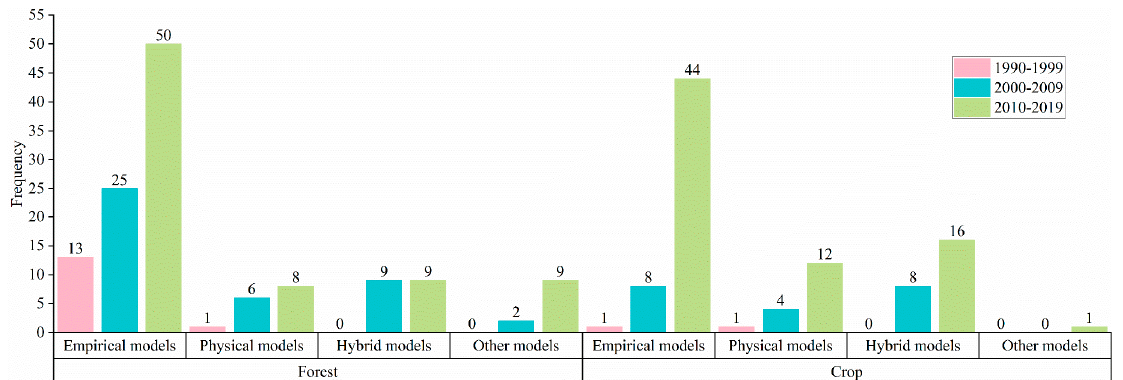
Figure 3. Temporal trends of number of papers published with four different model types for forest and crop LAI estimation from 1990–2019.